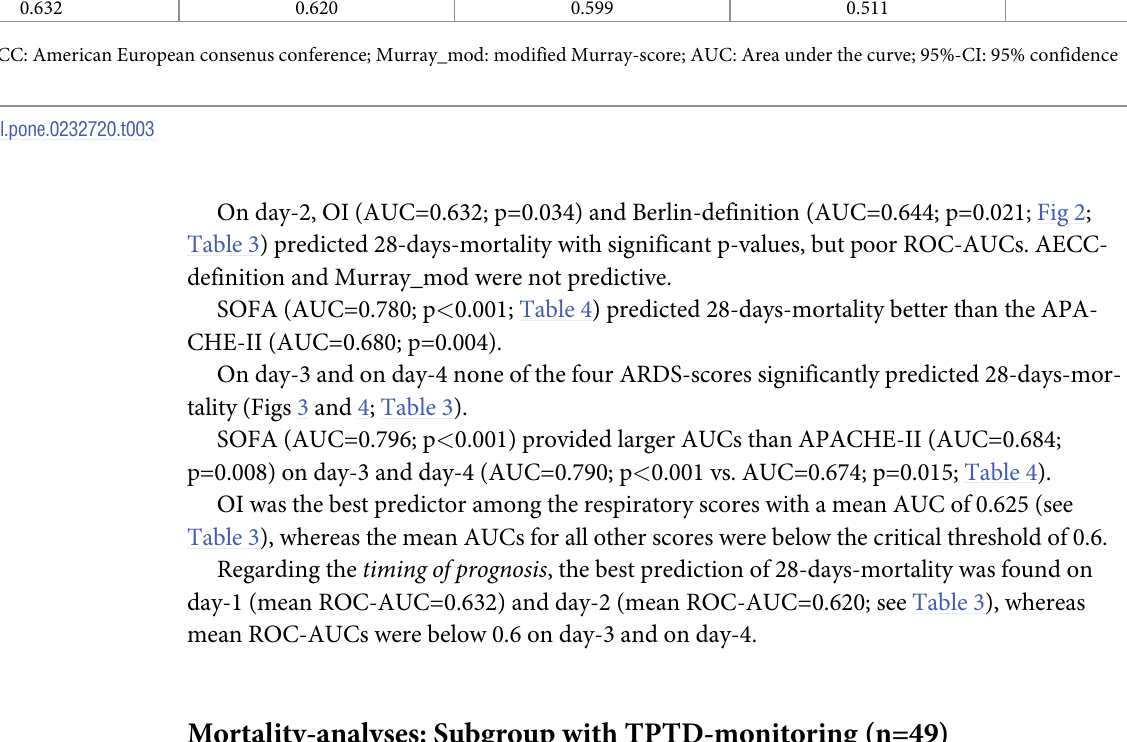
Mortality-analyses: Subgroup with TPTD-monitoring (n=49) Among patients with TPTD-monitoring, EVLWI had the best predictive capacities (Fig 5; Table 5): EVLWI provided the largest ROC-AUC on day-2 (AUC=0.786; p=0.001). EVLWI was also predictive on day-1 (AUC=0.712; p=0.018). EVLWI was the only parameter predict- ing 28-days-mortality on day-3 (AUC=0.692; p=0.035). The mean AUC for day-1 to day-4 was 0.696 for EVLWI (Table 5). OI was predictive on day-1 (AUC=0.789; p=0.001) and on day-2 (AUC=0.734; p=0.009), but not on day-3 and day-4. Next to EVLWI, OI provided the largest mean ROC-AUC (0.695; Table 5). Table 4. Prediction of 28-days-mortality by SOFA-and APACHE-II-score: All patients and patients with PiCCO-monitoring on all four days (d1-d4). Cohort/ Subgroup All patients Patients with PiCCO